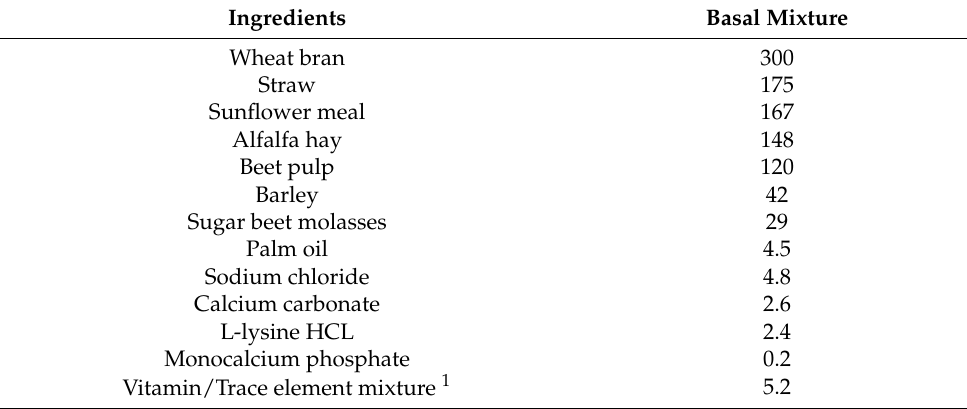
Table 1. Ingredients (g/kg) of the basal mixture.